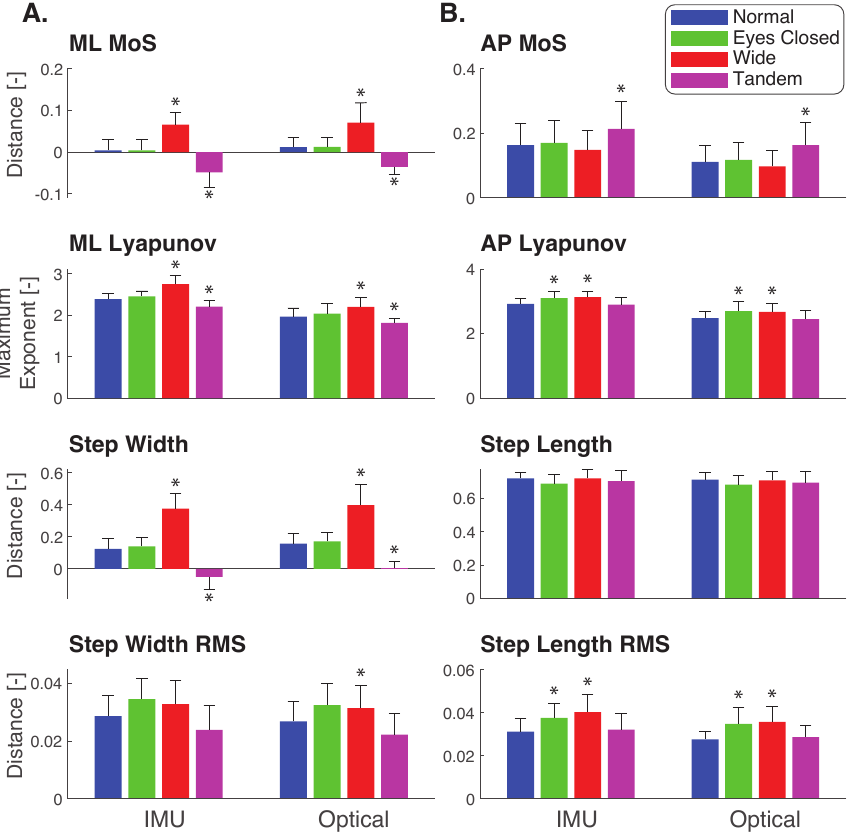
Figure 3. Stability and step placement measures derived from IMU and Optical data. Mean minimum MoS, maximum Lyapunov exponents, step placement, and step placement RMS variability for the ( A ) ML and ( B ) AP directions from IMU (left subcolumn) and Optical (right subcolumn) for Normal, Eyes Closed, Wide, and Tandem. Bars denote averages across all participants ( N = 10), and error bars denote one s.d. Statistically significant differences from the Normal condition indicated by an asterisk ( p <